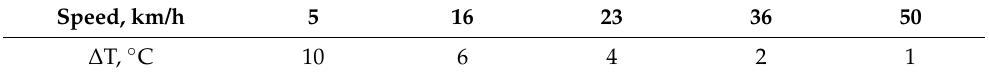
Table 5. Dependence of additional heating of primary winding on train speed with a preheated secondary. Speed, km/h